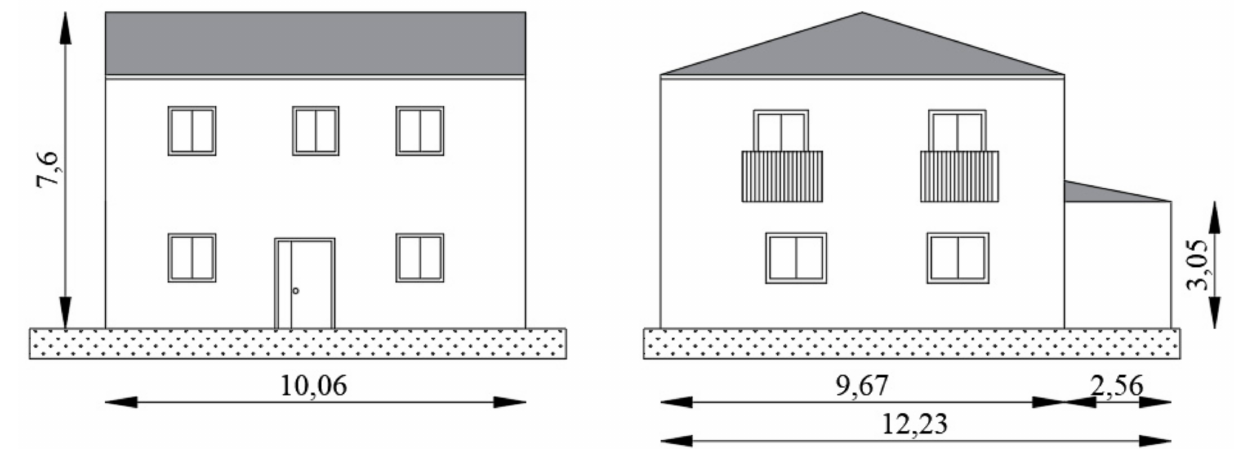
Figure 2. Prospects of the building with measures expressed in meters.